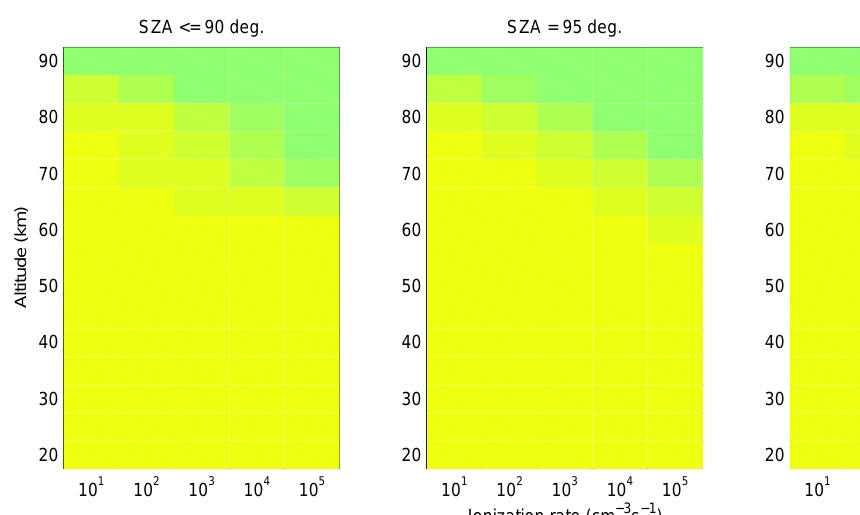
/Q for January 2